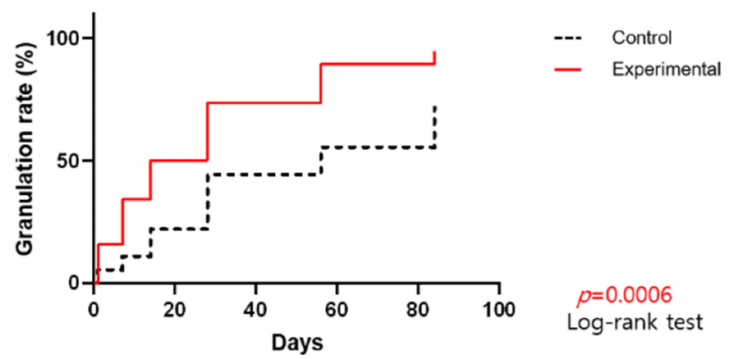
Figure 3. Percentage of granulation tissue in the wound by day.